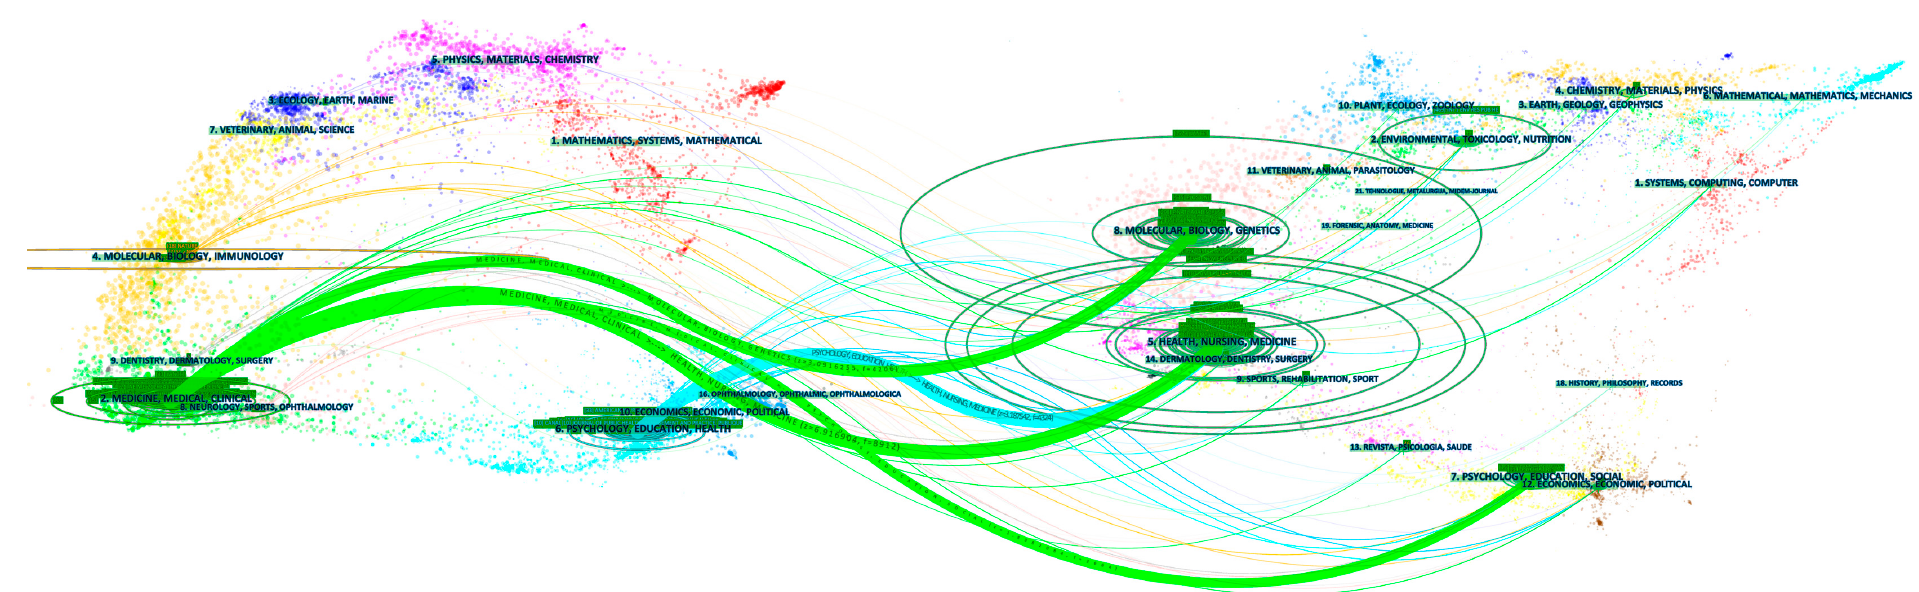
Figure 1. A subject matter overlay of publications on COVID-19-related health disparities. Note (s): wavelike curves represent citation links. They are colored by their source clusters. The dots in the clusters represent journals. The color of a dot denotes its Blondel cluster membership. The Blondel cluster membership is obtained by the Blondel algorithm [29].